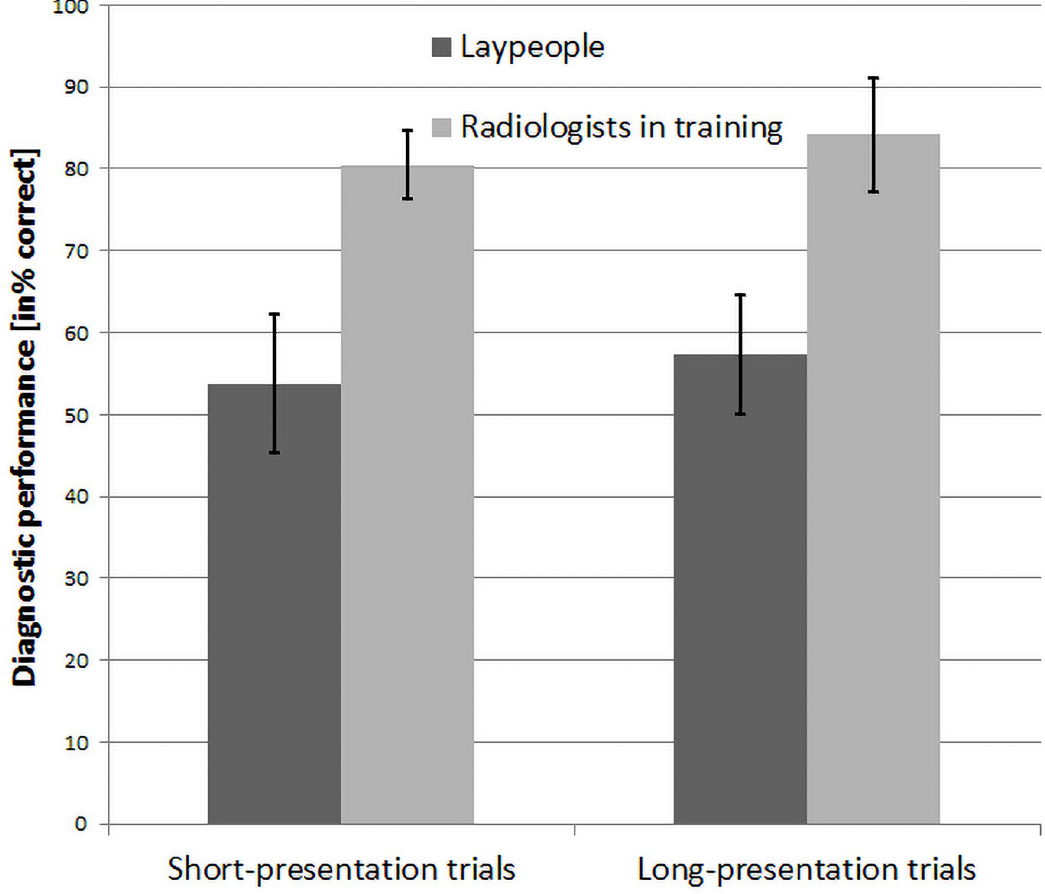
Fig 2. Average diagnostic performance (percentage of correct diagnoses) for laypeople and radiologists in training. Error bars show standard deviations. In both short-presentation trials and long-presentation trials, radiologists in training scored significantly higher than